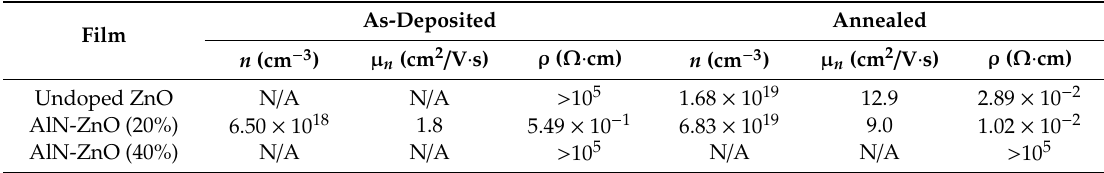
Table 1. Carrier concentration, mobility, and resistivity of the as-deposited and annealed undoped ZnO films as well as the cosputtered AlN-ZnO films at a theoretical Al atomic ratio of 20% and 40%.